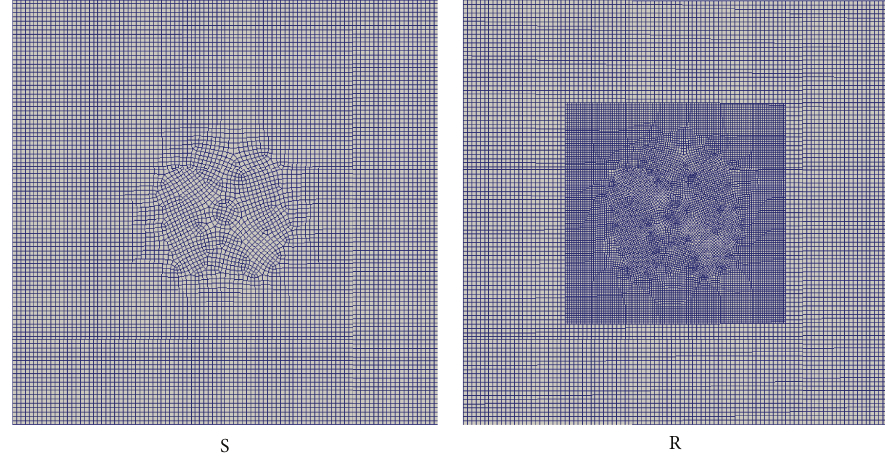
Figure 2: Top view of standard (S) and refined mesh